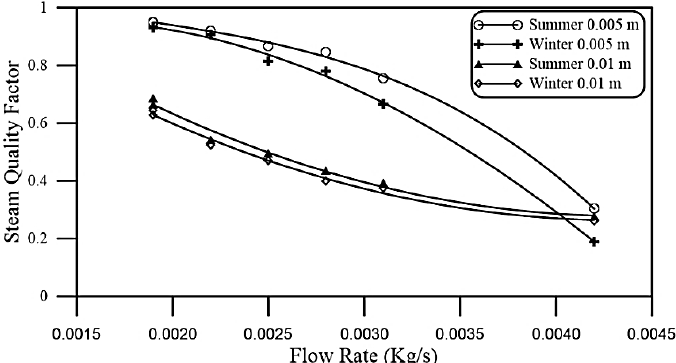
Figure 16. Steam quality factor for the 0.005 m and 0.01 m tubes in winter and